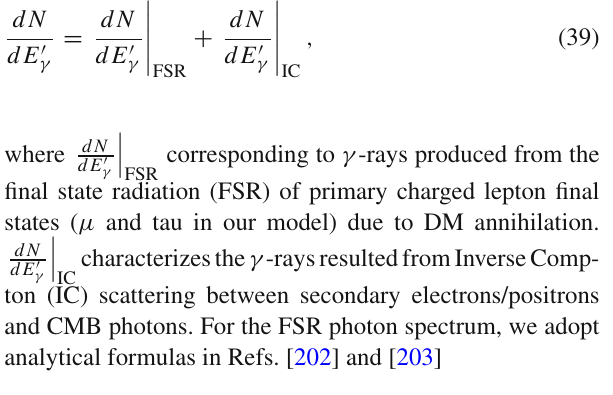
Fig. 6 The positron fluxes predicted by benchmarks of N N → Z (cid:3) Z (cid:3) (Table 3) and N N → Z (cid:3) H 0 (Table 4) annihilation channels with the fitting results of AMS-02